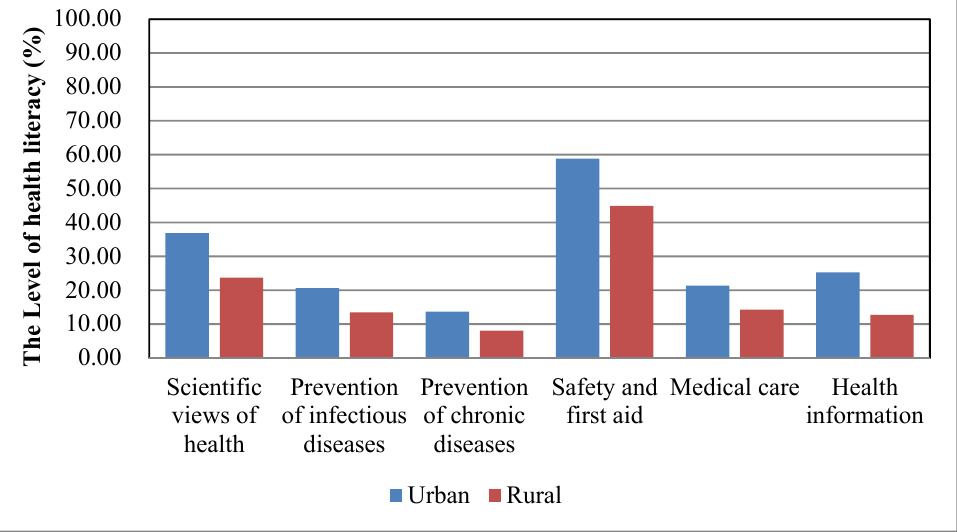
Table 2. Odds ratios in favor of having basic health literacy and 95% CI in the stepwise logistic regression.